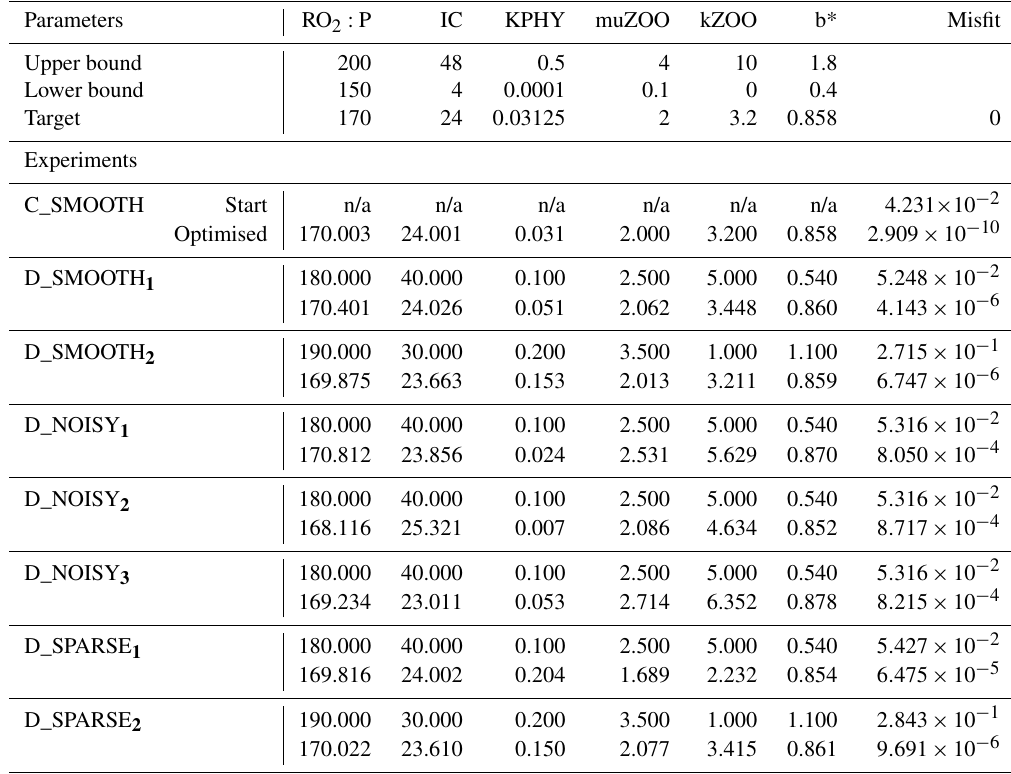
Table C1. Optimised parameters for all twin experiments. Upper section shows parameter bounds and MOPS-ref target parameters to be recovered. Lower section shows each experiment’s results. Columns 2–7: (first row) starting parameter values and (second row) optimised pa- (first row) the starting global misfit and (second row) the lowest global misfit. n/a: not applicable for CMA-ES.